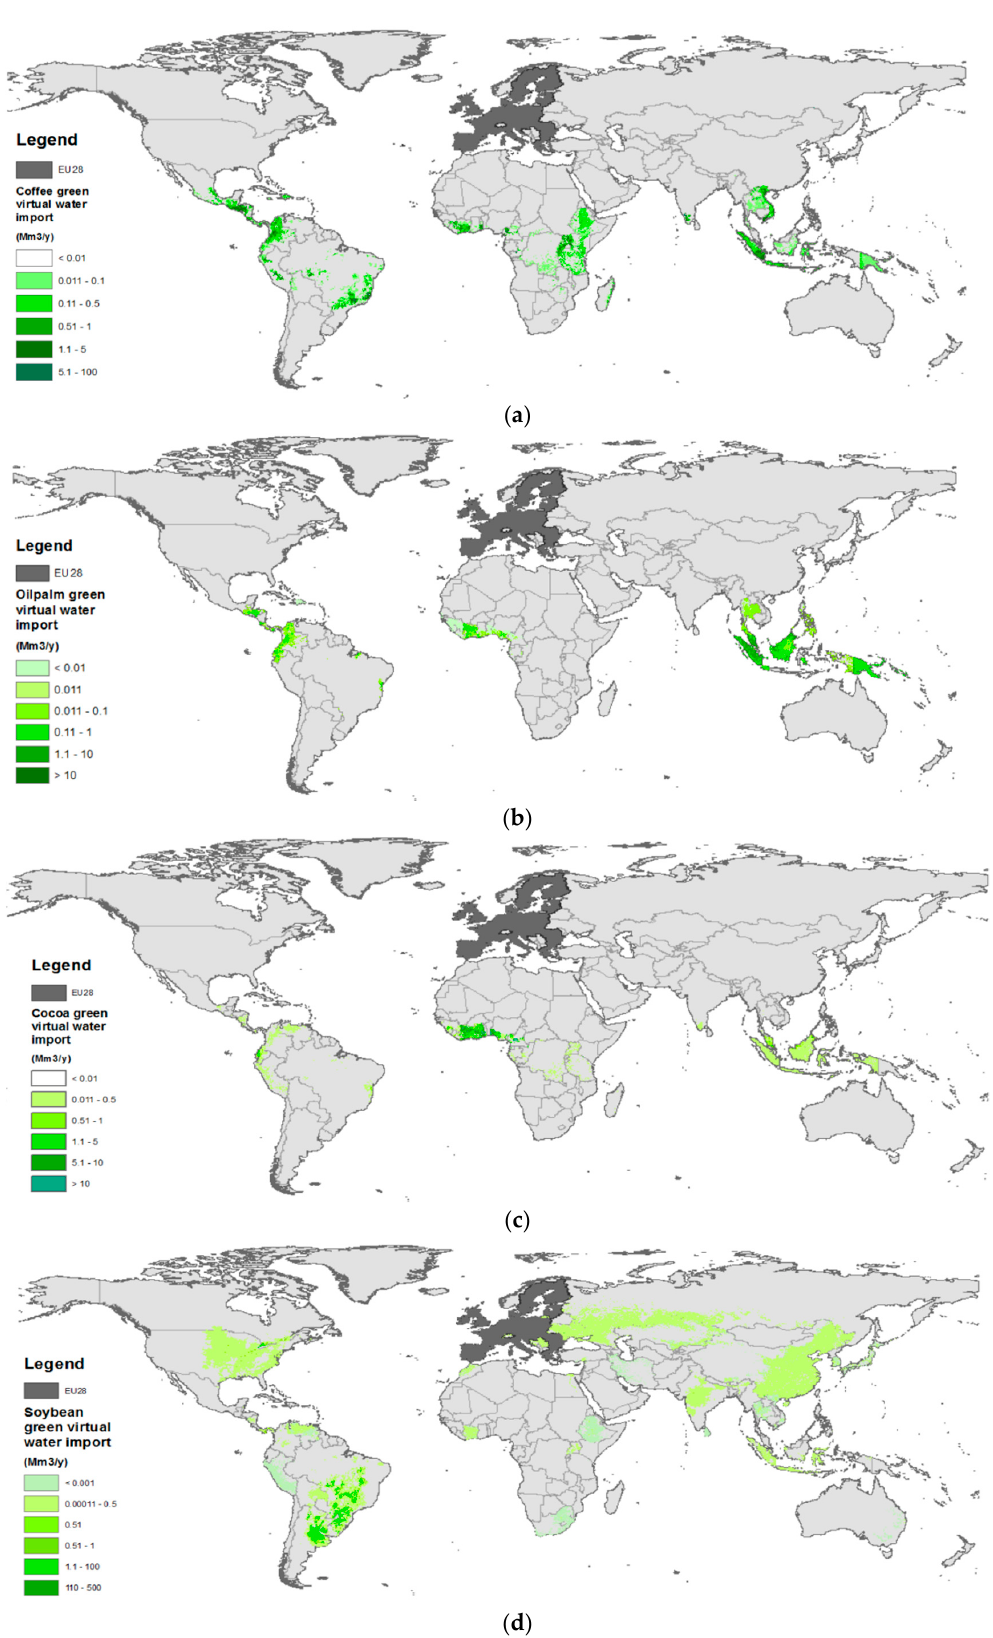
Figure 6. Green virtual water imports to the EU per grid cell related to co ff ee ( a ), oil palm ( b ), cocoa ( c ) and soybean ( d ) (million m 3 /